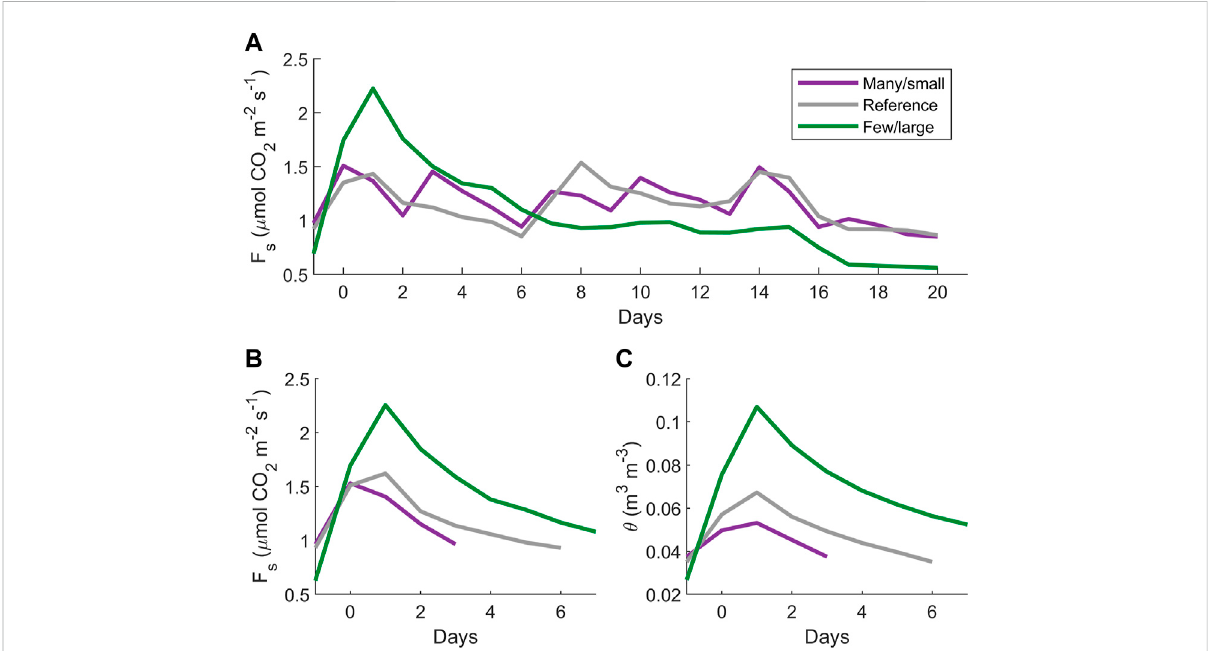
FIGURE 3 (A) Representative mid-growing season period showing soil CO 2 ef fl ux (F s ) responses to irrigation events observed 23 August – 13 September 2020 with x-axis showing days since 23 August. Lower panelsshow the fi rst 7 days of themean pulse response of (B) F s and (C) 0 – 10 cm volumetric soilmoisture( θ )forthethreelevelsofrainfallrepackagingaveragedacrossallirrigationeventsfortheentiredurationoftheexperiment.In (B) and (C) the x-axis indicates days since irrigation event.